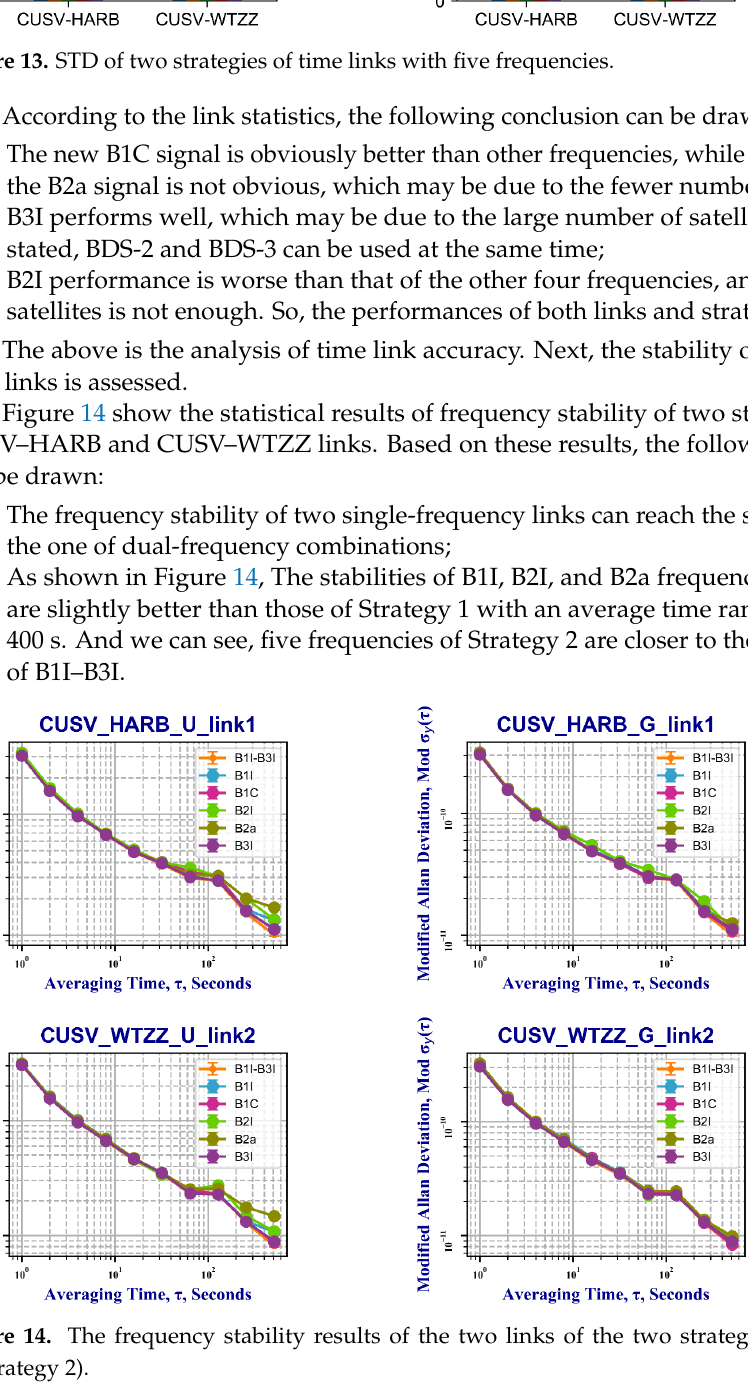
Figure 13. STD of two strategies of time links with five frequencies.